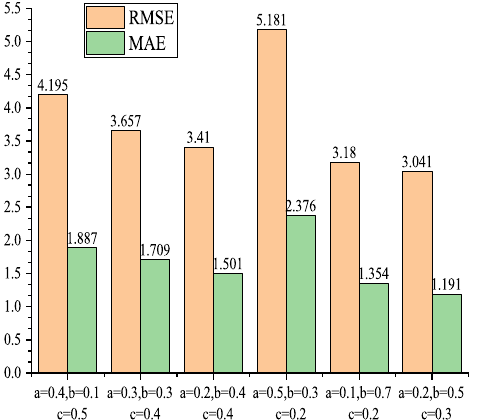
Figure 6. RMSE and MAE values for different generator weights.